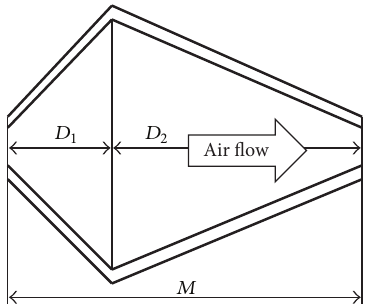
Figure 10: Schematic illustration of the shape of a tooth.